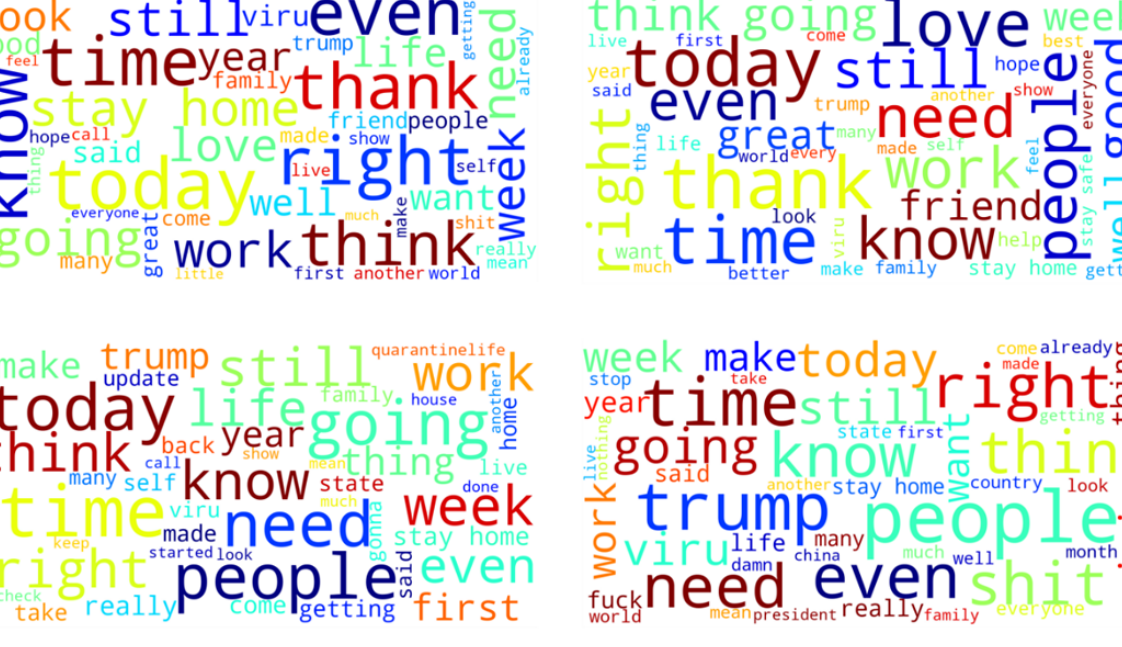
Figure 3. Word clouds showing the most frequently used word stems across Twitter users' post descriptions related to coronavirus disease (COVID-19). The upper left image is a word cloud formed from all tweets, while the upper right image is formed from tweets of positive sentiment. The lower left image is formed from tweets of neutral sentiment, while the lower right image is formed from tweets of negative